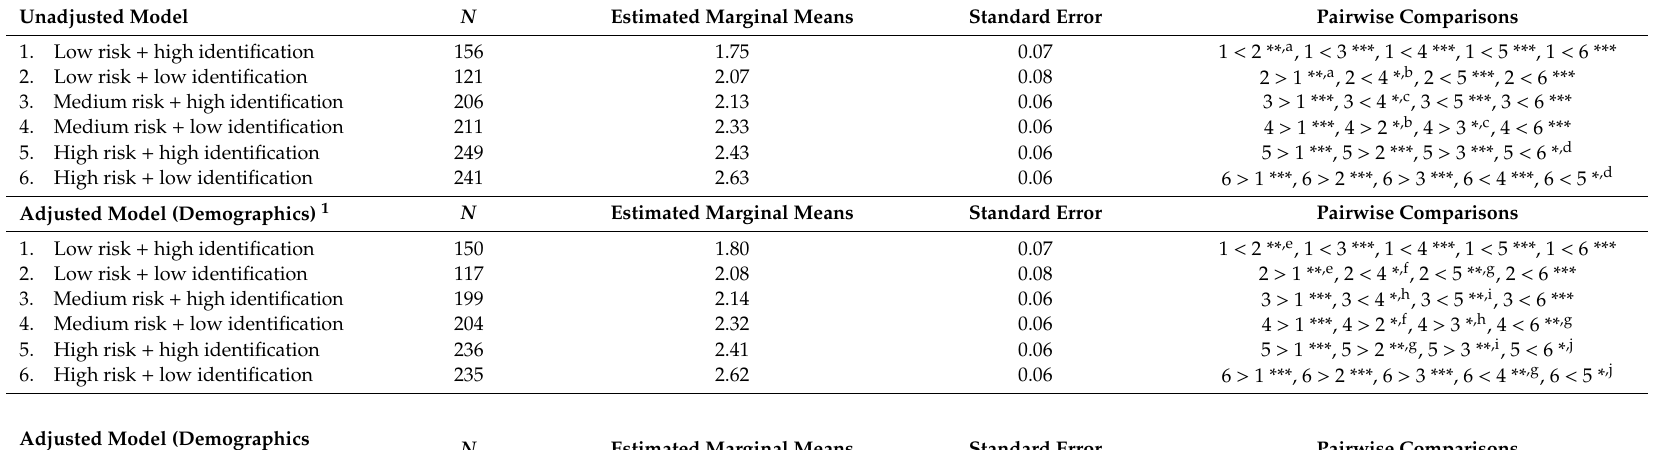
Table 4. Unadjusted and adjusted combined e ff ects of perceived COVID-19 infection risk and work community identification on stress symptoms ( N = 1015–1184). Unadjusted Model N Estimated Marginal Means Standard Error Pairwise